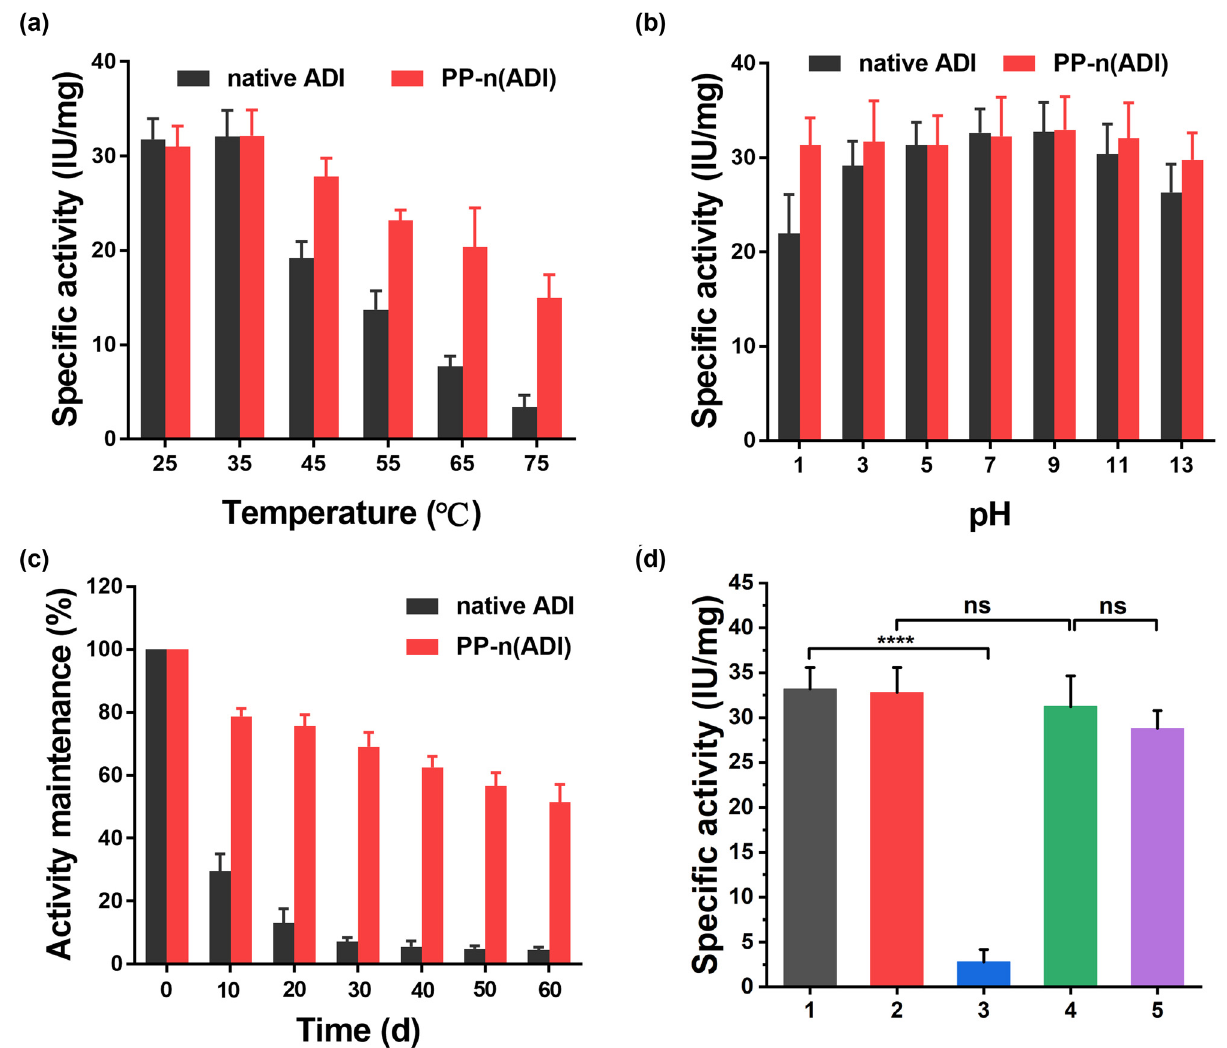
Figure 5: ( a ) The measurement of the speci fi c activities of samples that were stored at di ff erent temperatures for 30 min. ( b ) The mea - surement of the speci fi c activities of samples that were stored in solutions with di ff erent pH values for 30 min. ( c ) Samples were pre - incubated with the same volume of fresh mice serum and stored at 37 ℃ for 60 days, and their activity was measured every 10 days. ( d ) Before and after incubation with trypsin, the speci fi c activity of samples was measured. 1: native ADI; 2: PP - n ( ADI ) ; 3: native ADI treated with trypsin; 4: PP - n ( ADI ) treated with trypsin; 5: PP - n ( ADI ) fi rst treated with glucose and then treated with trypsin. The signi fi cance levels were **** p < 0.0001 and ns p >